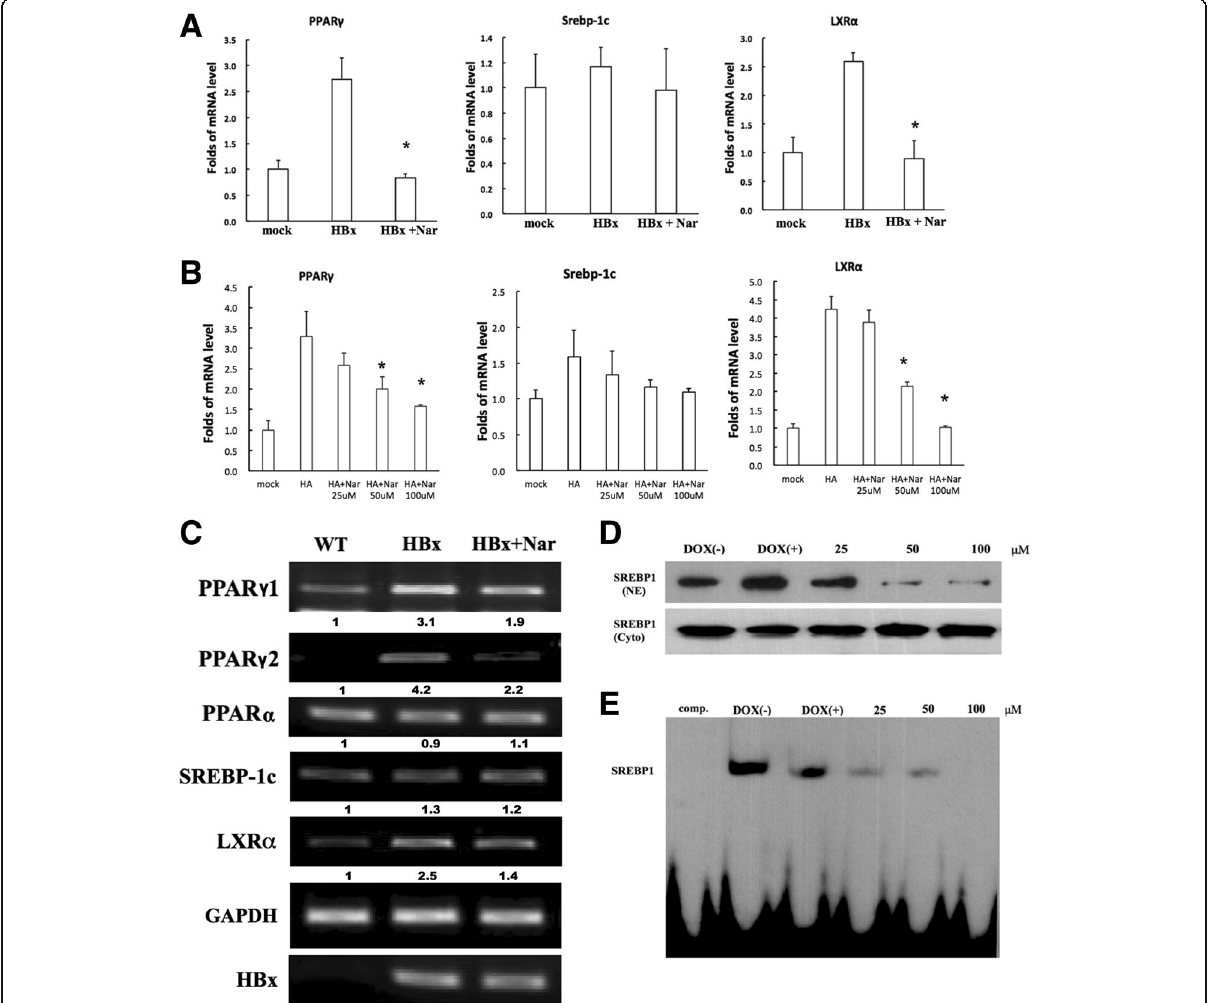
Fig. 4 The effect of naringenin (Nar) on the expression of genes associated with lipogenesis in the HBx-transgenic livers. a Expression of the mRNAs encoding PPAR γ , SREBP1-c, and LXR α in the livers of wild-type (WT) mice and in the livers of HBx-transgenic mice without and with 14 days of once- daily Nar treatment (30 mg/kg/d), as assessed by RT-PCR. b Expression of the mRNAs encoding PPAR γ , SREBP1-c, and LXR α in HepG2 cells that had been mock-transfected (mock), or stably transfected with the HBx-GFP construct (HA) and grown in the presence of 0, 25, 50, or 100 μ M Nar, as assessed by real-time PCR. c Repeat of the experiment portrayed in Panel A, this time using reverse transcription-PCR. Amplification products were electrophoresed, stained with ethidium bromide, and visualized using a transilluminator. d Nar attenuates HBx-induced nuclear translocation of the SREBP1 protein in HepG2-HBx cells. HepG2-HBx cells were grown in the absence of inducer (DOX( − )) or in the presence of inducer and Nar at 0 (DOX(+)), 25, 50, or 100 μ M Nar. After 24 h of growth, cells were harvested, and the nuclear extract (NE) and cytoplasmic (Cyto) fractions were generated and processed for immunodetection of the SREBP1 protein as described in the Methods section. e Nar attenuates HBx-induced activation of the SREBP1 protein in HepG2-HBx cells. Cultures were grown as in Panel d , and samples collected after 24un hours were processed for biotinylated electrophoretic mobility shift assays as described in the Methods section. For Panels a and b , data are presented as mean±SD from each group of 5 animals. Asterisk indicates a significant difference ( p <0.05 by two-tailed unpaired t test) comparing HBX mouse ± Nar or HepG2-HBx±Nar. For Panels c , d , and e , reactions were performed with samples from individual mice or cultures; results are representative of those seen for biological